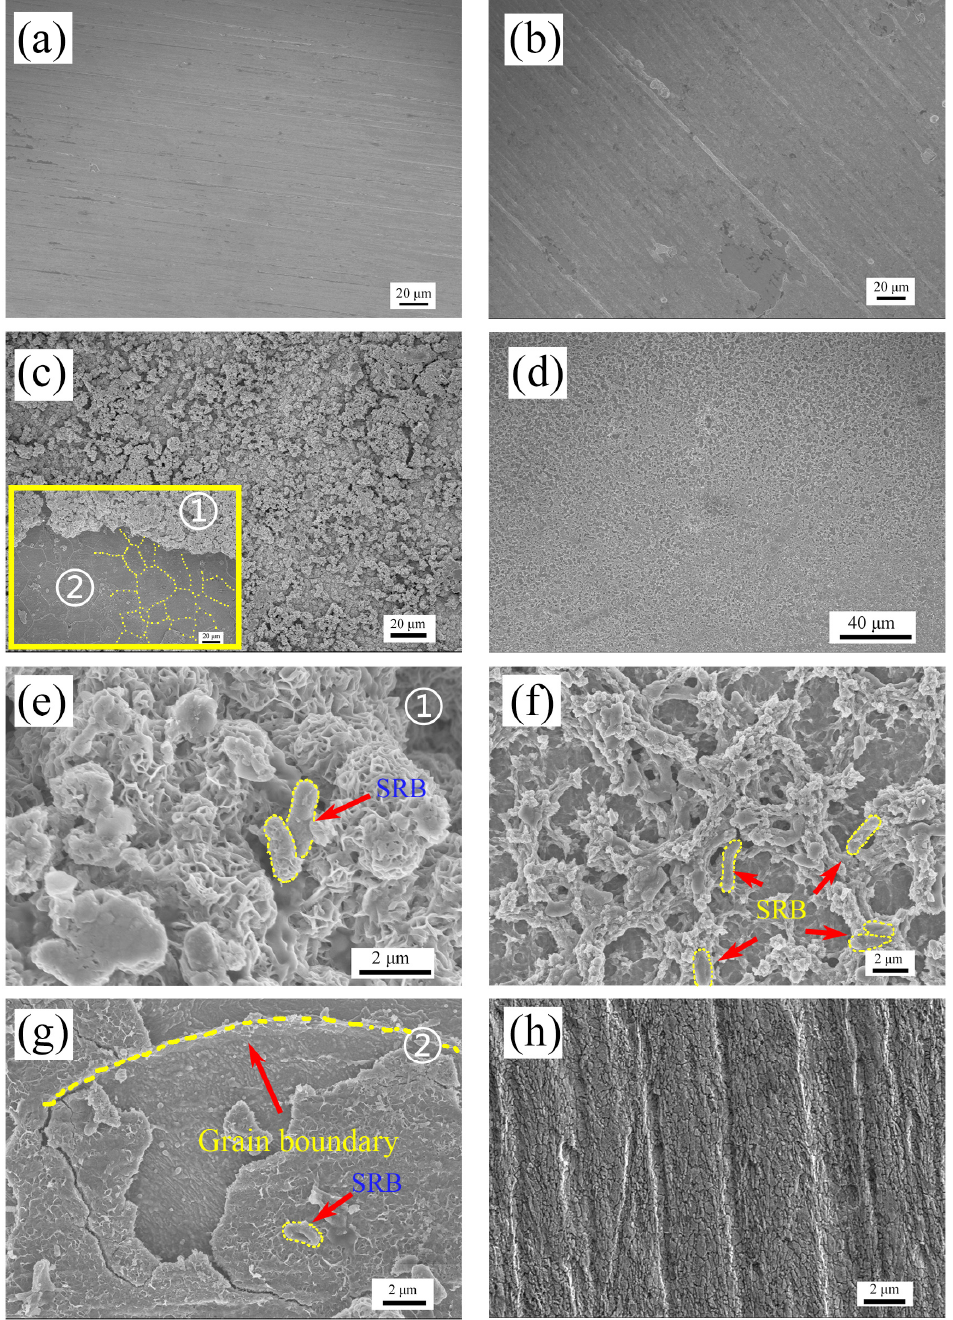
Figure 1. The surface morphologies of ( a ) the original Q235 coupon, ( b ) the coupon obtained in the sterile medium, and ( c – f ) the coupon obtained in the SRB-Z-inoculated medium; ( e ) region ① with cauliflower-like product, ( g ) region ② the bulgy grain boundary, ( d , f ) the network-like products, and ( h ) the corrosion morphology under the network-like product.